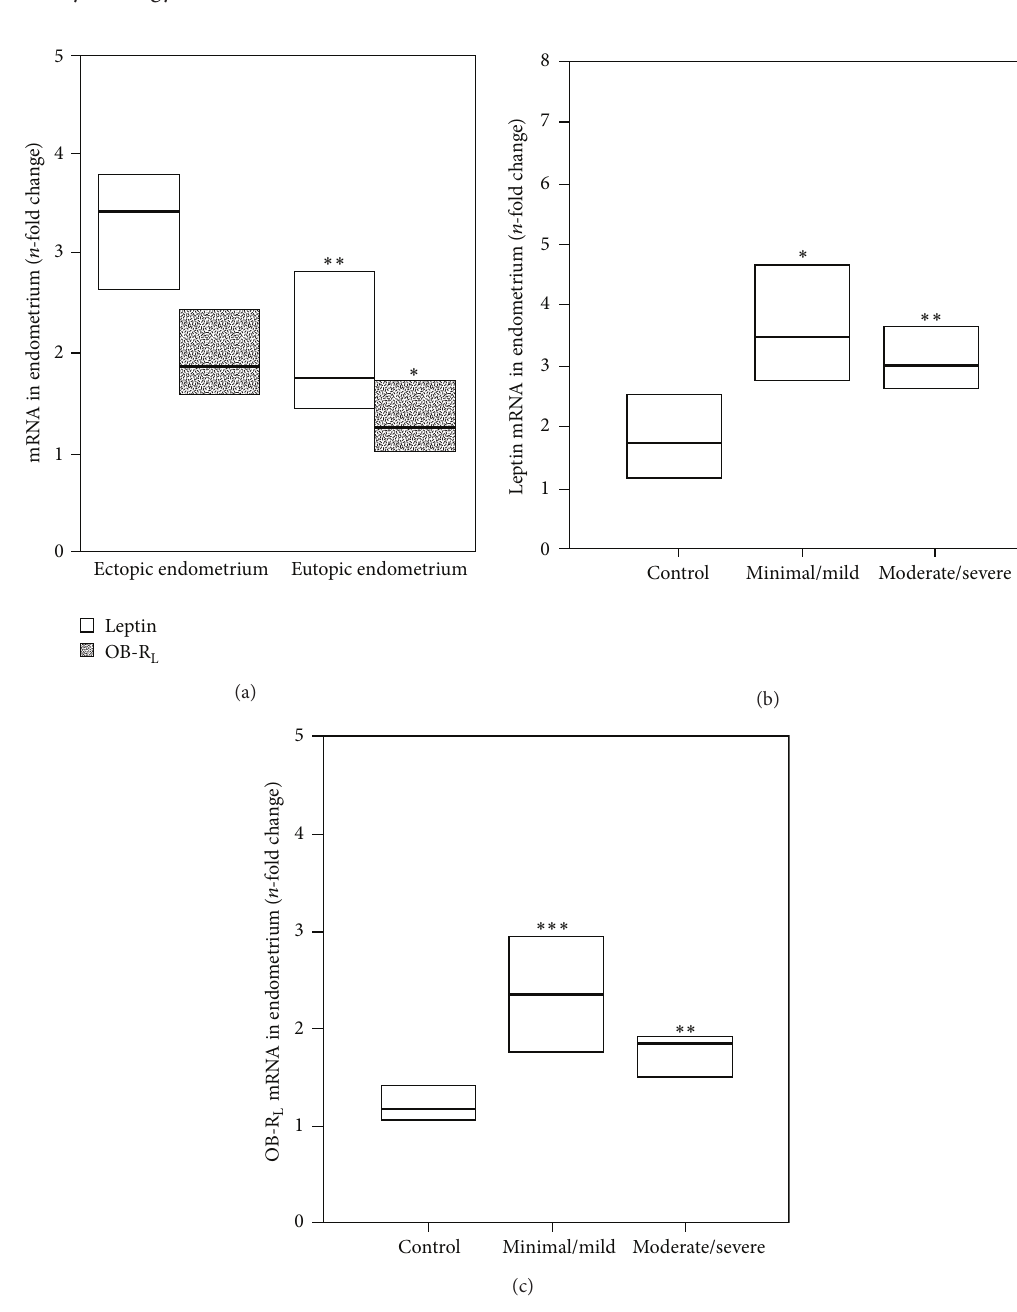
Figure 1: Leptin and long leptin receptor isoform (OB-R L ) gene expression in endometriosis. (a) Ectopic endometrium and eutopic endometrium of patients with endometriosis. Values are expressed as n -fold difference in relation to the calibrator sample ( ΔΔ Ct method). ∗∗ 𝑃 < 0.001 (leptin mRNA ectopic versus eutopic endometrium); ∗ 𝑃 < 0.05 (OB-R L mRNA ectopic versus eutopic endometrium) (Wilcoxon signed-rank test). (b) Leptin gene expression and (c) long leptin receptor isoform (OB-R L ) in eutopic endometrium of non-endometriosis controls and ectopic endometrium of minimal/mild and moderate/severe endometriosis. Values are expressed as n-fold difference in relation to the calibrator sample ( ΔΔ Ct method). Asterisks indicate significant difference in comparison to controls. ∗ 𝑃 < 0.05 ; ∗∗ 𝑃 < 0.01 and ∗∗∗ 𝑃 < 0.001 (Mann-Whitney U